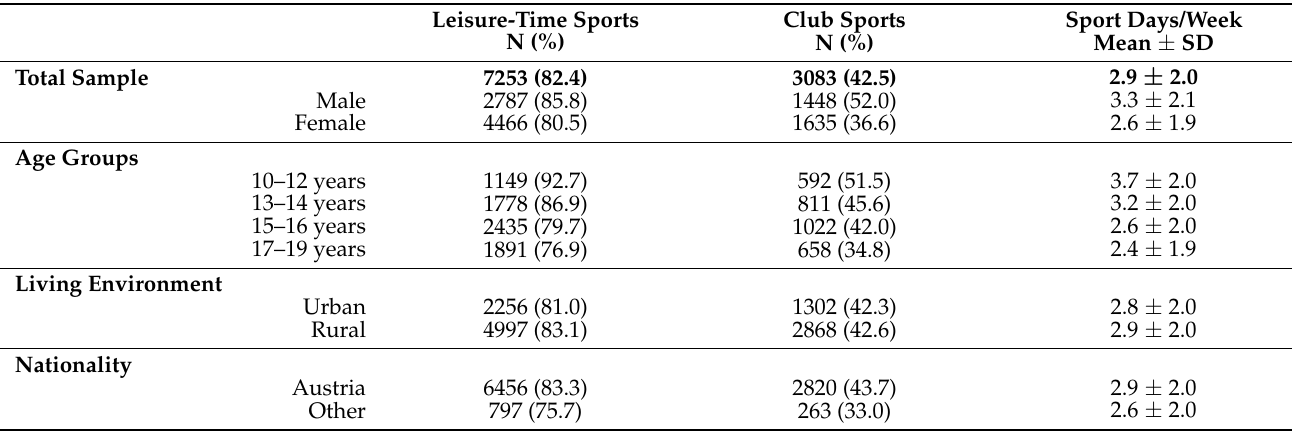
Table 3. Sports participation by sex, age, living environment, and nationality. Values are the number of participants (N) and prevalence (%) as well as mean with standard deviation for the number of days with sports.